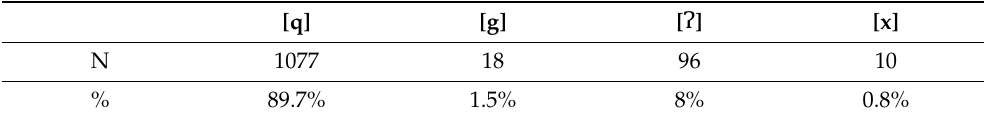
Table 5. Voiceless uvular and its variants distribution.